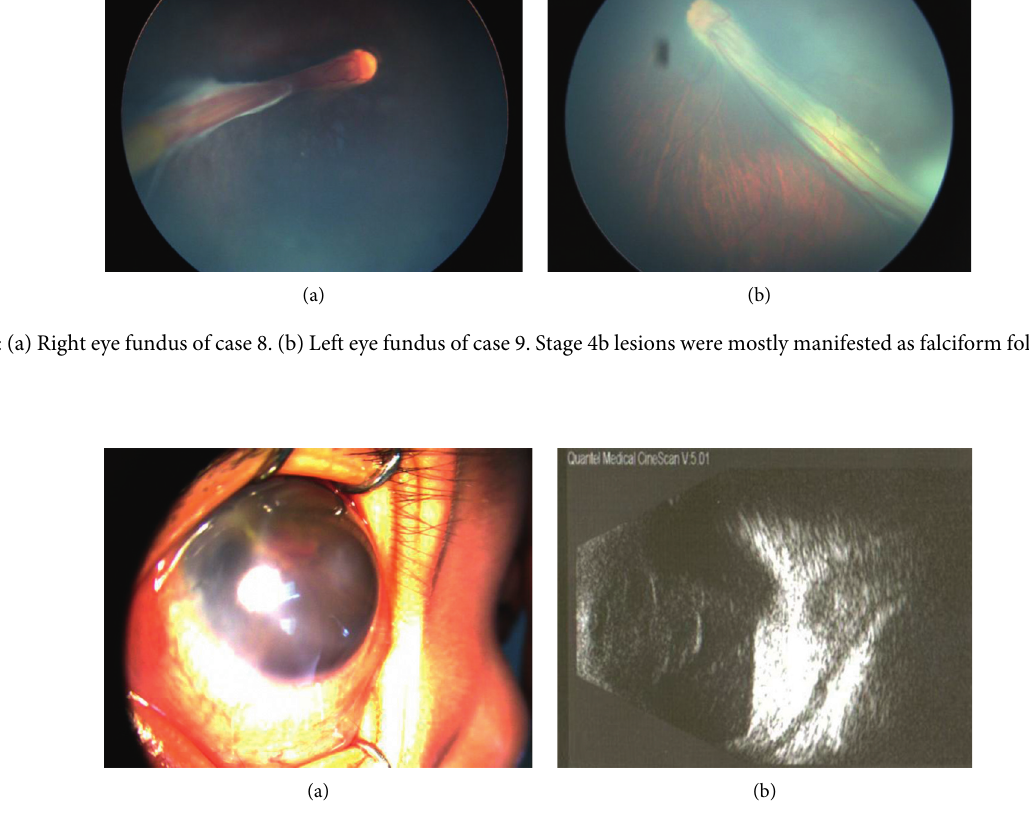
Figure 5: Right eye of case 4. (a) Flat anterior chamber. (b) B-scan of the right eye showed funnel-form retinal detachment.